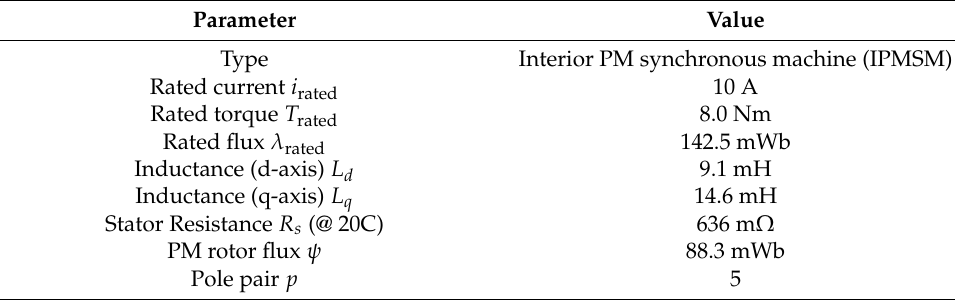
Figure 2. ( top ) ( left ) The d-axis flux linkage map, ( middle ) q-axis flux linkage map, and ( right ) torque function. ( bottom ) ( left ) The d-axis iso-flux lines, ( middle ) q-axis iso-flux lines, and ( right ) iso-torque lines. Table 2. PMSM motor drive